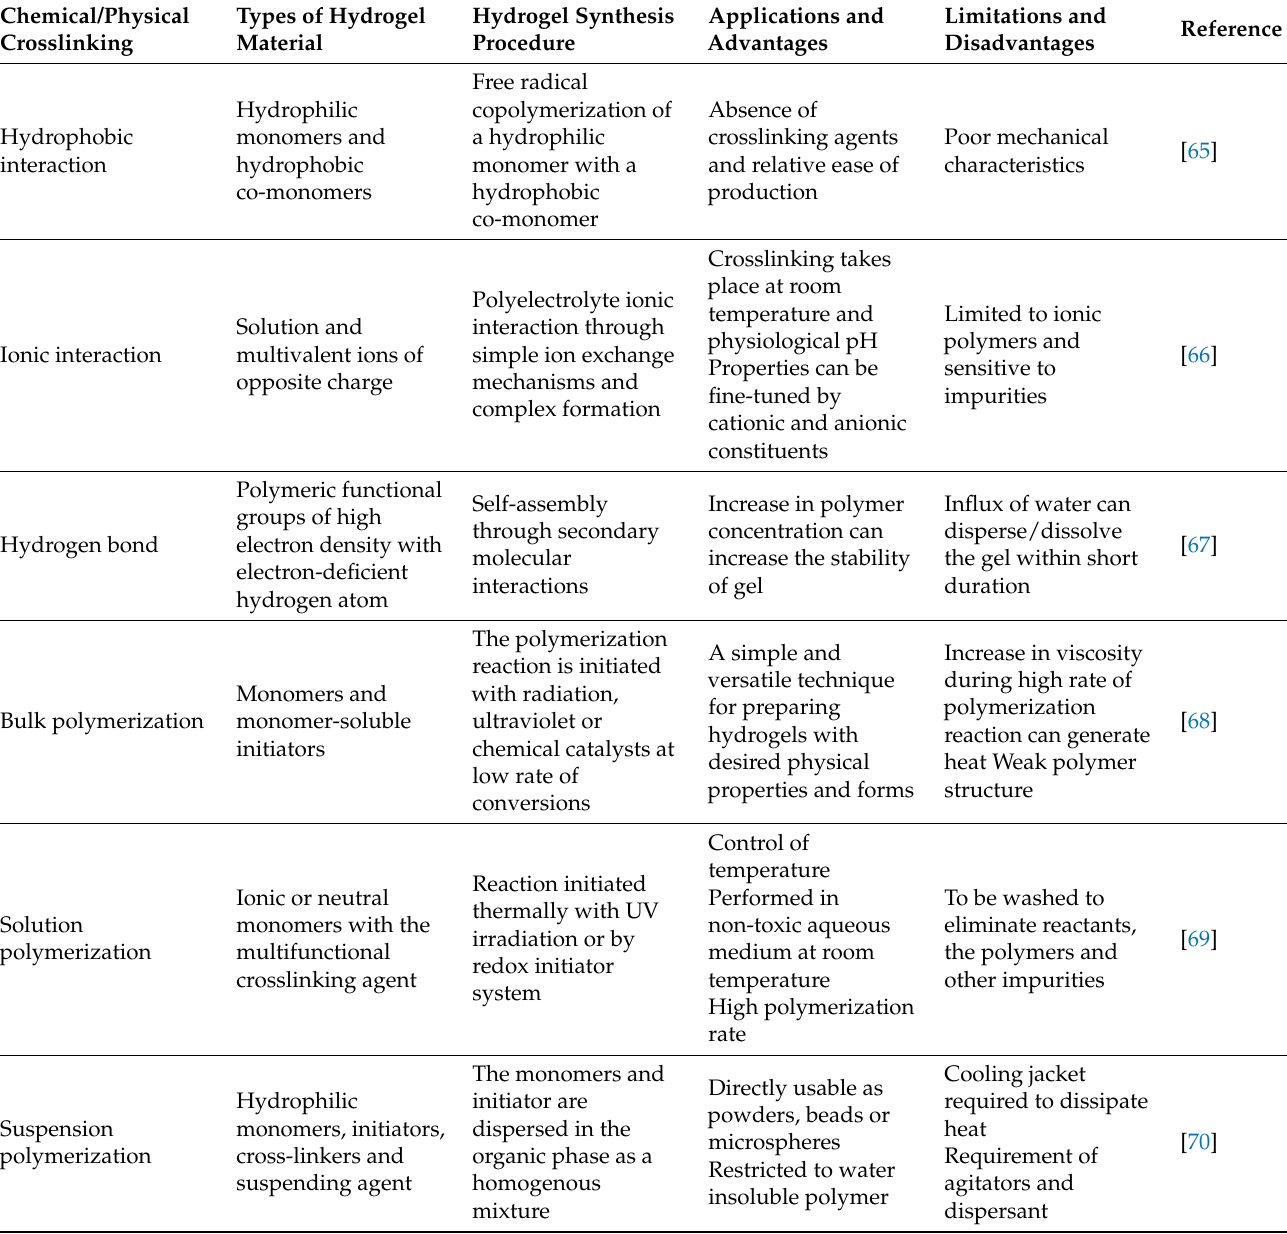
Table 5. Injectable hydrogels synthesized through chemical and physical crosslinking methods, their application and